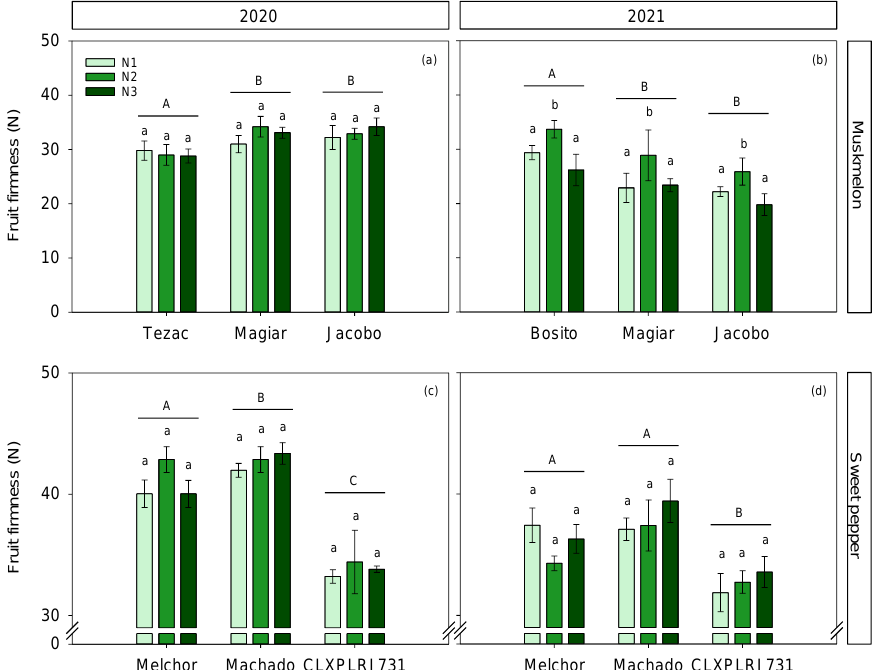
Figure 2. Fruit firmness for three cultivars and three N treatments, for muskmelon ( a , b ) and sweet pepper ( c , d ) crops, conducted in 2020 and 2021 years. In muskmelon, the measurements were internal; in sweet pepper, the measurements were external. Different lowercase letters show significant differences between N treatments within each cultivar; different uppercase letters show significant differences between cultivars. Values are means ± SE.